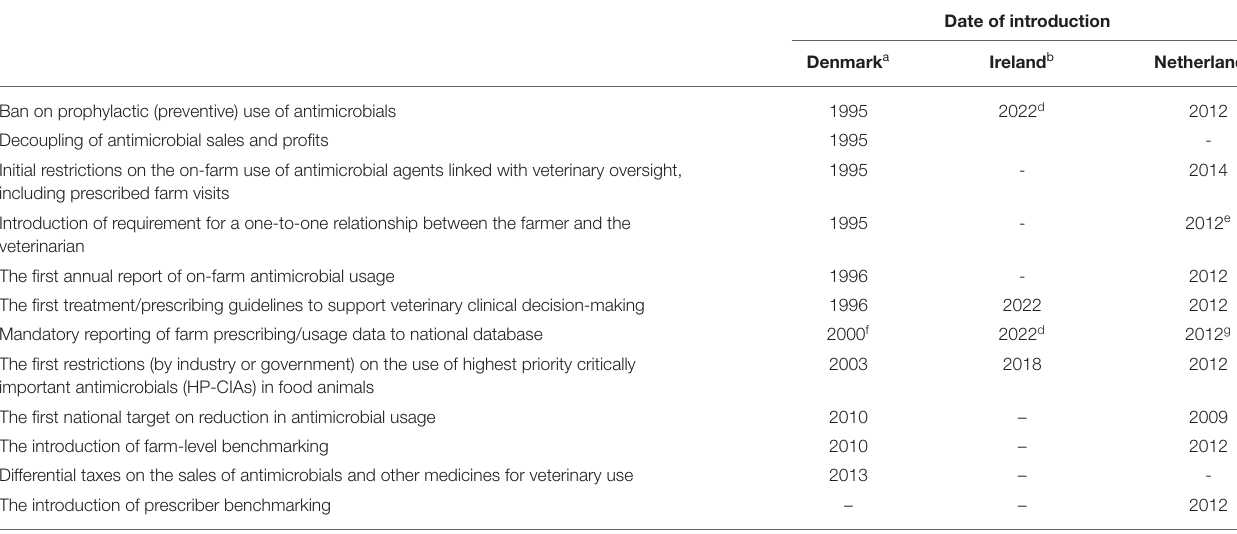
TABLE 1 | Comparison of antimicrobial stewardship in farm animal production in Denmark, Ireland and the